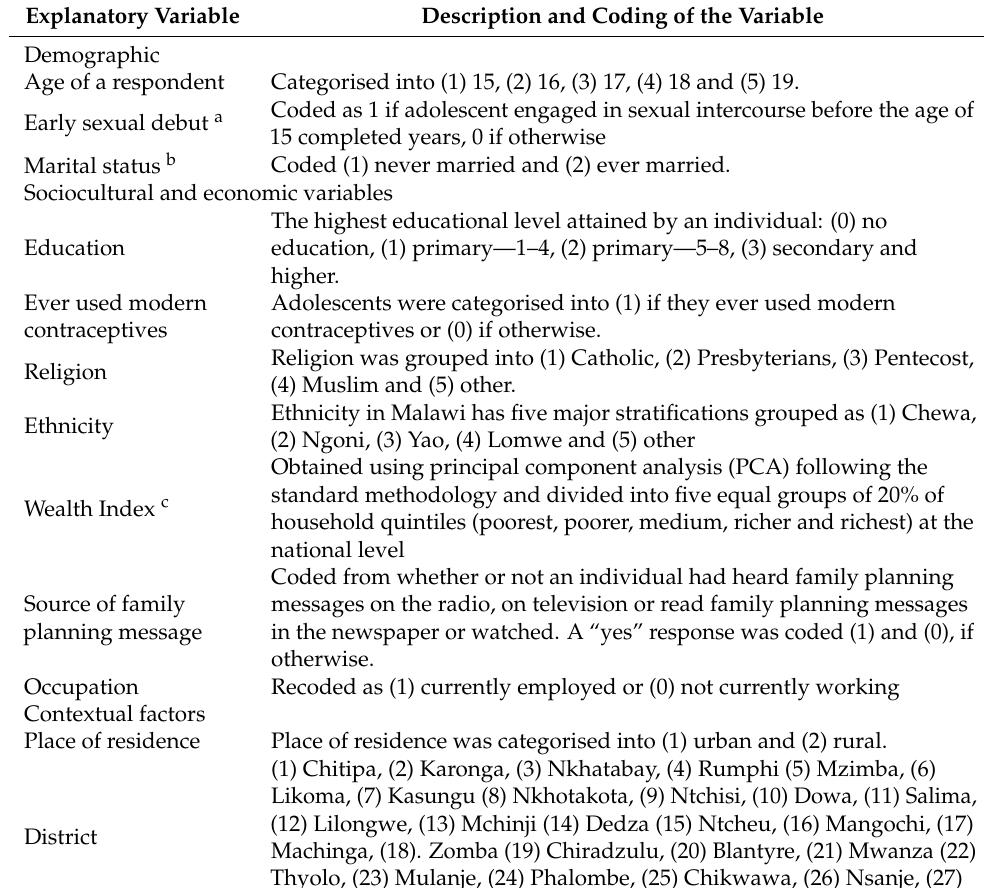
Table 1. Description of independent